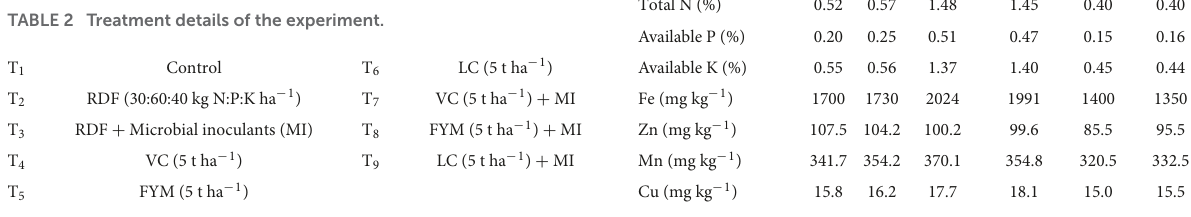
Growth parameters were observed and recorded as per standard methodology and protocols. Plant height was taken from the base region to the tip of the longest branch at 30, 60, and 90 days after sowing (DAS) and at the maturity stage.